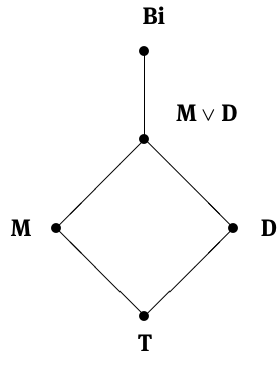
Fig. 1. The lattice of subvarieties of